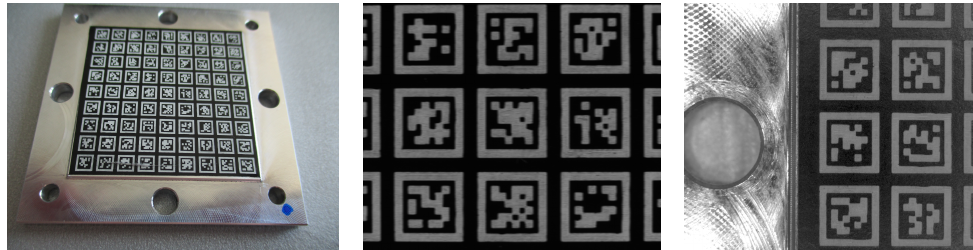
Figure 8. Manufactured AprilTag array: ( left ) photography of the AprilTag array, ( center ) general image of the camera’s field of view, and ( right ) image of the camera’s field of view at the edge of the working